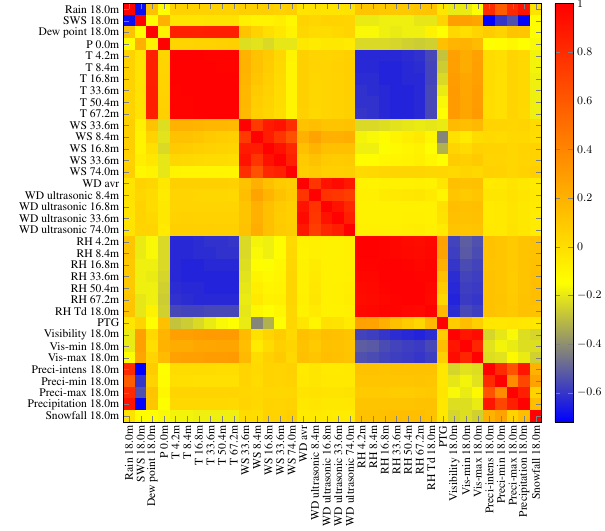
Fig. 1. Correlations between input sensors. Figure 1. Correlations between input sensors. Figure 1. Correlations between input